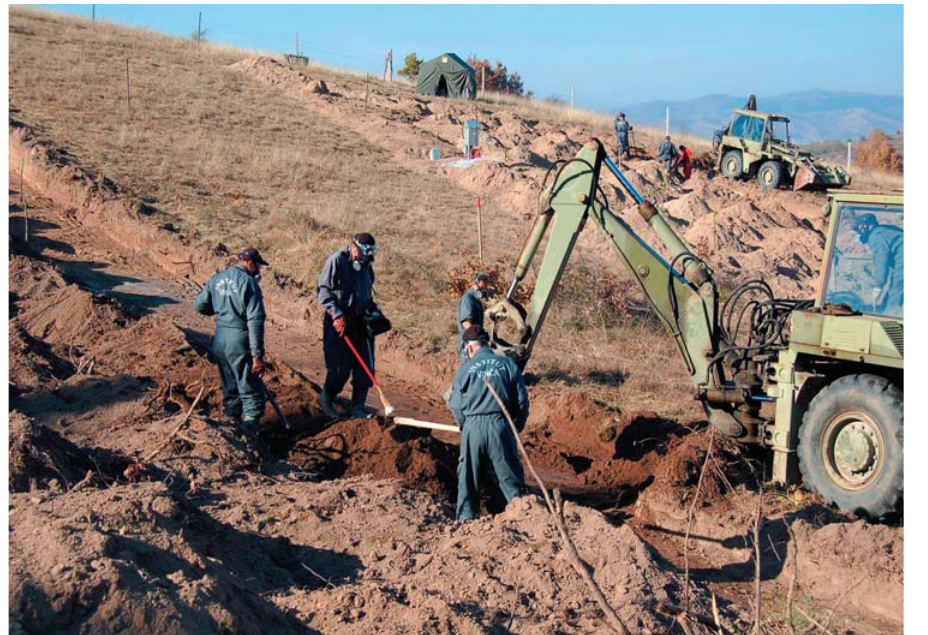
Figure 10 – Soil decontamination using engineering machines Рисунок 10 – Обеззараживание почвы инженерными